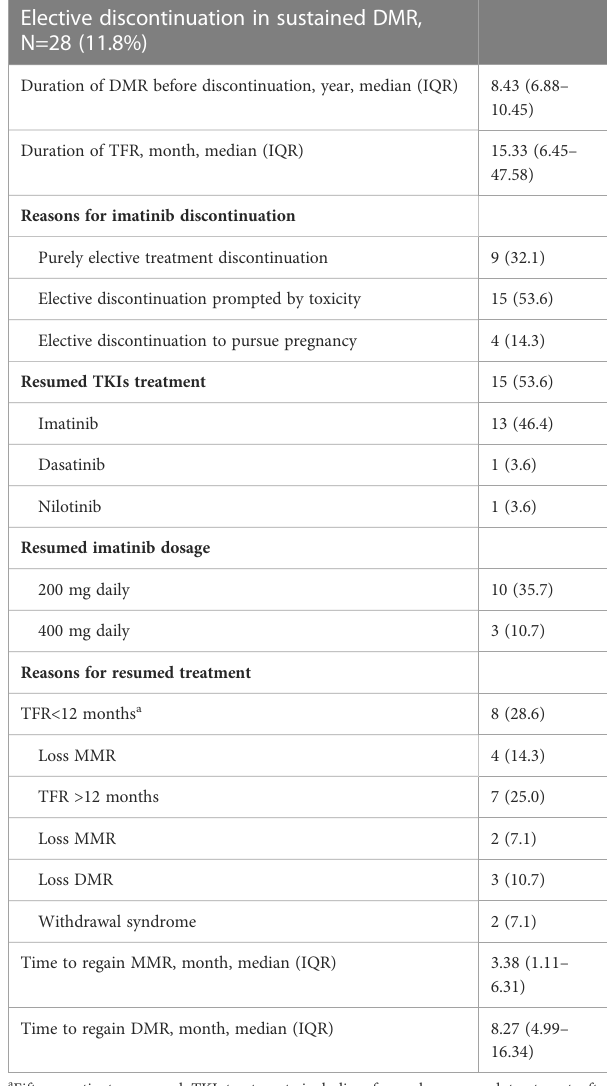
TABLE 5 Imatinib discontinuous therapy.